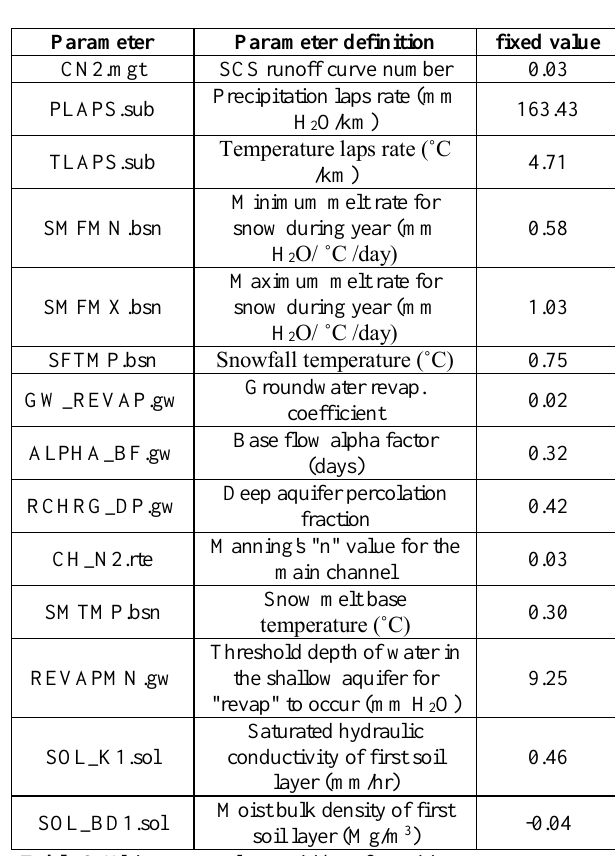
Table 2. Ultimate actual magnitides of sensitive parameters to discharge.